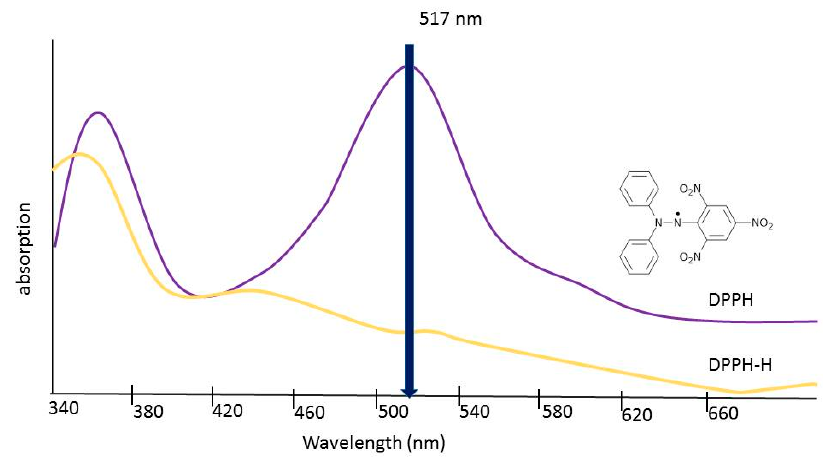
Figure 4. DPPH absorption spectra.